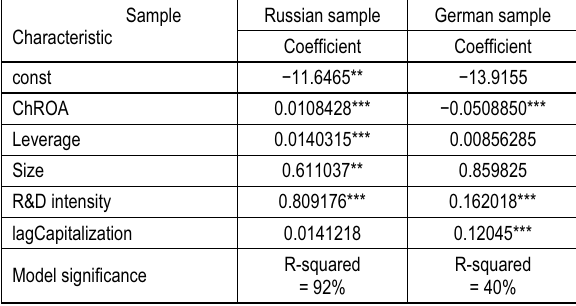
Table 4. Comparative research